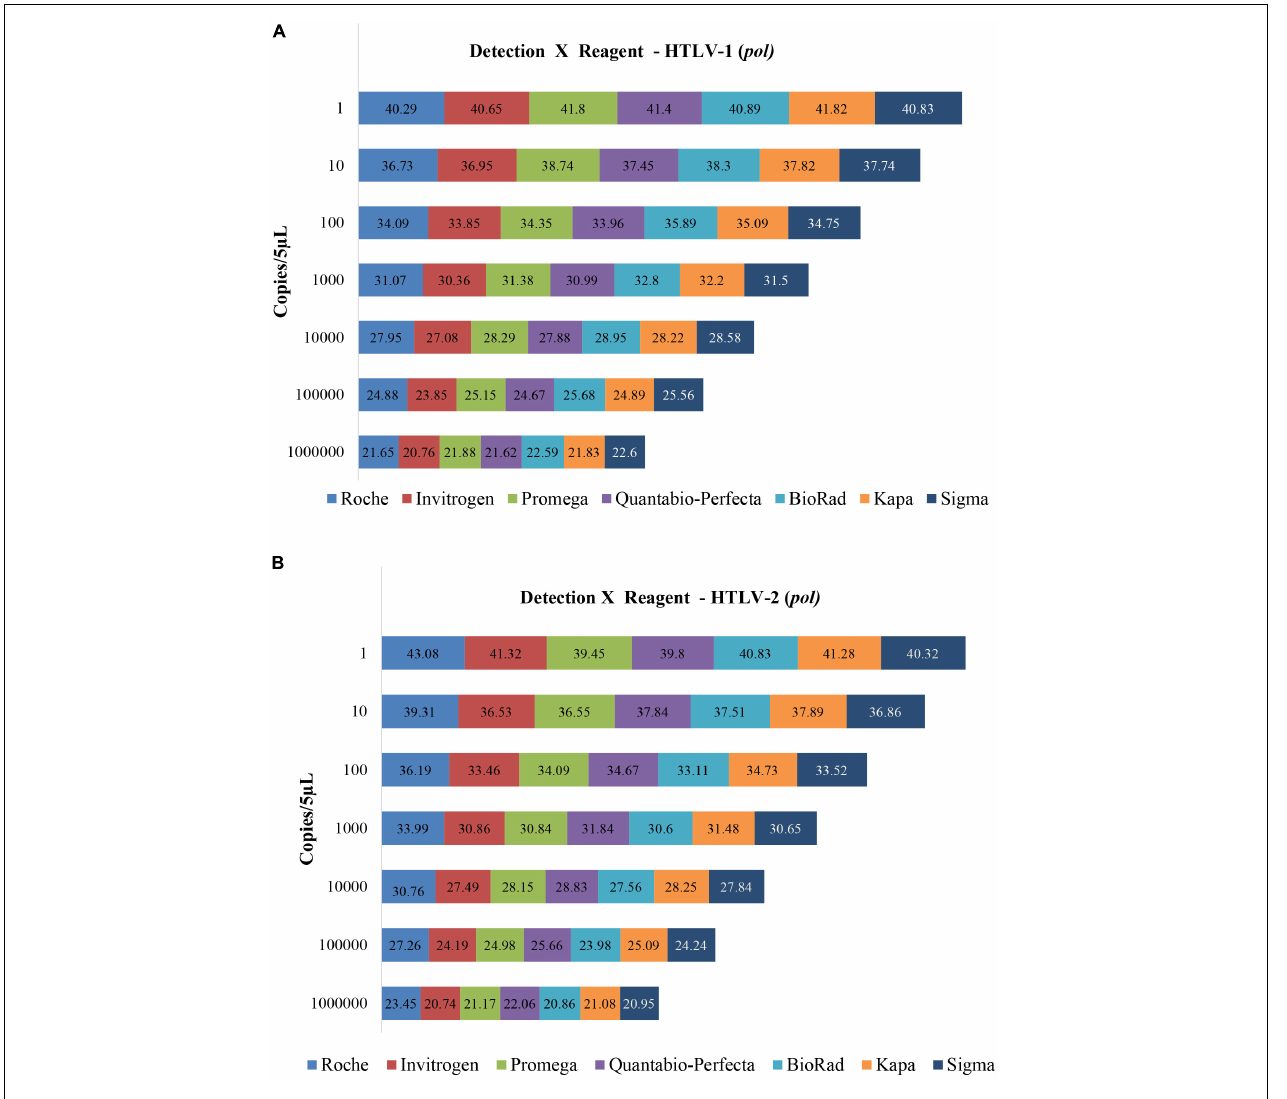
FIGURE 2 | Limit of copy number detection of the mqPCR_HTLV assay ( pol ) for detecting HTLV-1 (A) and HTLV-2 (B) using plasmids and seven different master mix trademarks, and ROCHE LightCycler 480II equipment. The Cq values are disclosed inside the